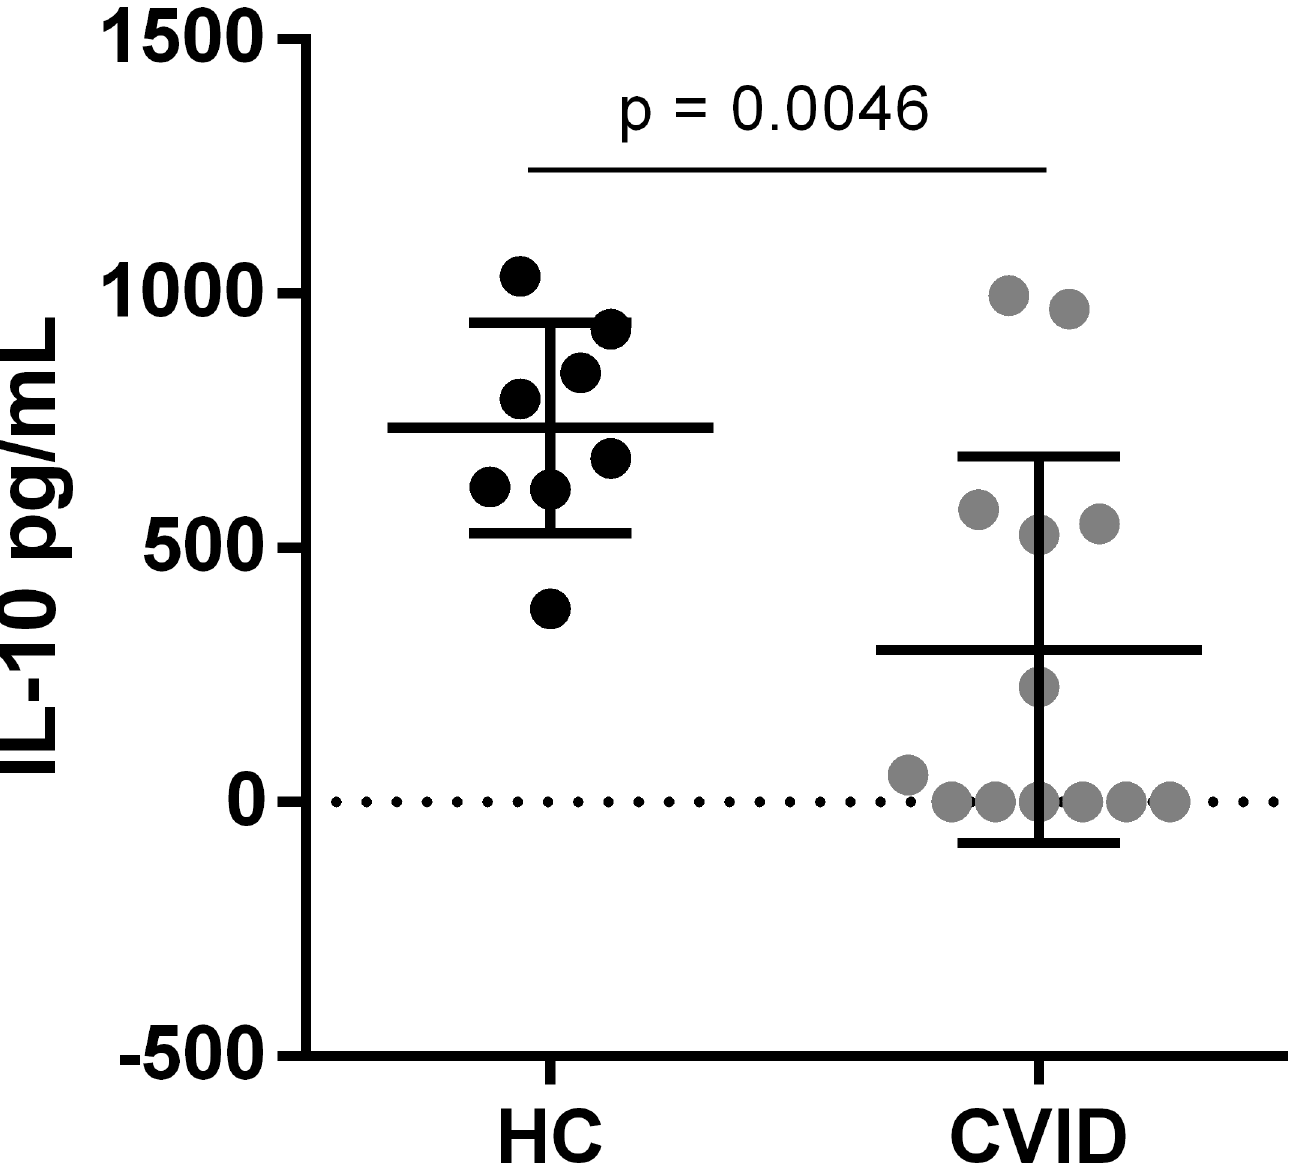
Fig 3. IL-10 production by B cells from CVID patients and healthy controls. IL-10 production from sorting-purified B cells of 9 healthy controls (HC) and 13 CVID patients was determined in the supernatant of cultures with CpG and CD40L for 48 hours by ELISA. Bar graphs represent mean IL-10 production ( ± SEM). P values were calculated by Mann-Whitney